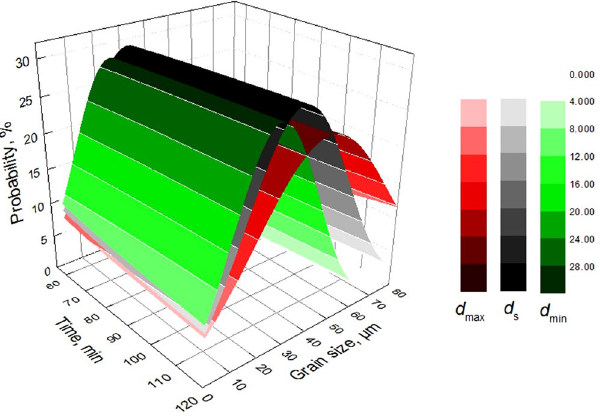
Figure 13. The probabilities of the occurrence of different grain sizes after heating at 860